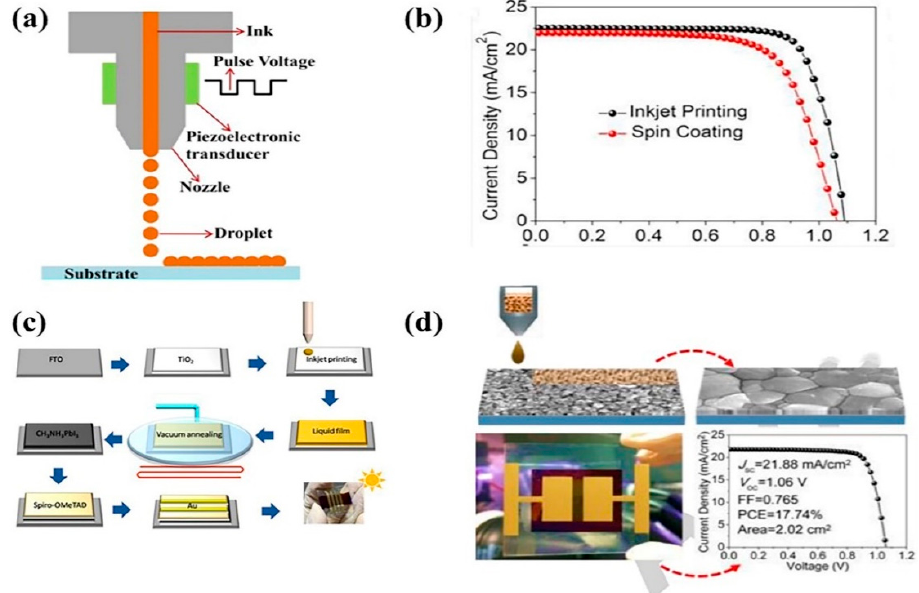
Figure 10. ( a ) Schematic diagrams for continuous ink-jet printing methods. Copyright 2018 Royal Society of Chemistry [119]. ( b ) J–V characteristics of ink-jet printing and spin coating-based PSCs [121]. Copyright 2018 Elsevier. ( c ) Schematic diagram of PSC fabrication through ink-jet printing with vacuum annealing [120]. Copyright 2018 John Wiley and Sons. ( d ) J–V curves of PSCs on ink-jet printing with active area 2.02 cm 2 [121]. Copyright 2018 Elsevier.